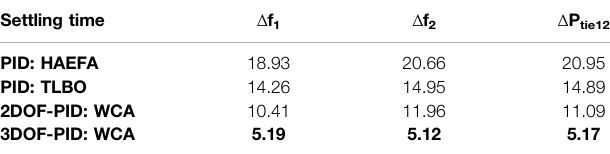
TABLE 2 | Response settling time (in s) with various controllers for the DAHT